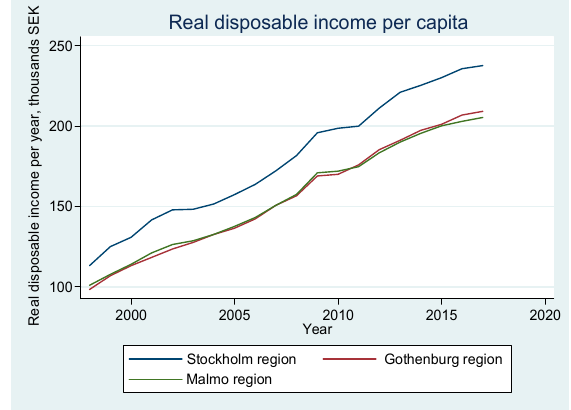
Figure 8. Real disposable income per capita in the three largest urban areas in Sweden.